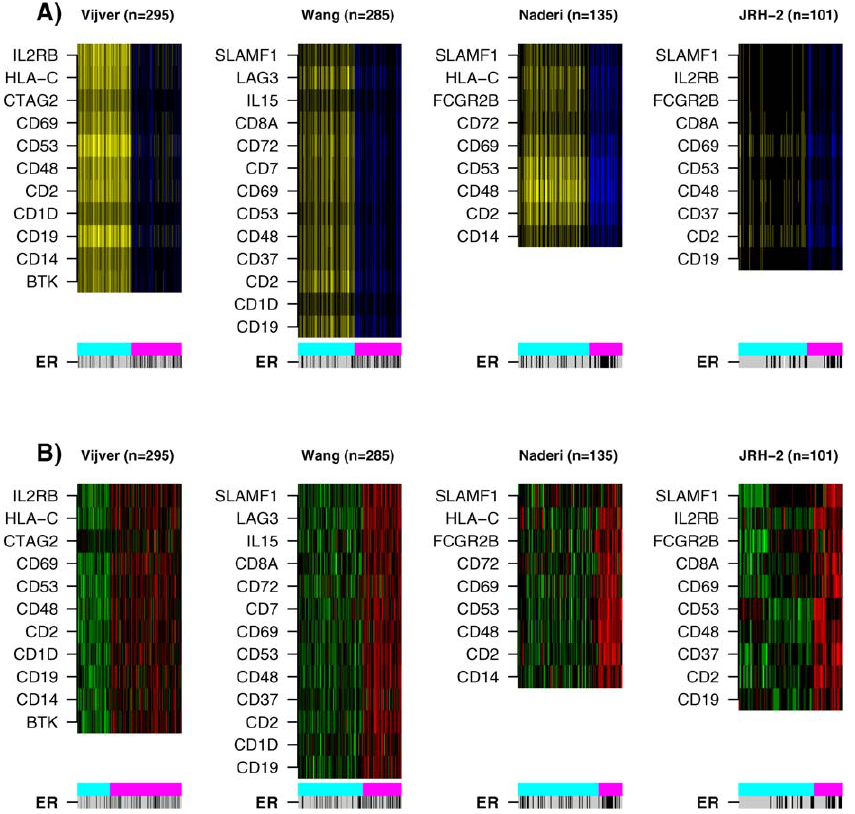
Figure 5. The Association of Immune Response with Estrogen Receptor Status (A) For each major breast cancer cohort, we give the heatmap of component expression values for the component enriched for the immune-response pathway characterised in [39]. Thus, the heatmap matrix shown is S gk A ks where k is the component enriched for the immune response pathway, g is any gene found on the array that is also in the pathway and the selected feature set of the component, and s denotes the tumour sample. Samples have been ordered according to a k-means (k ¼ 2) clustering over the set of genes. The ICA algorithm for which this heatmap is shown is the KernelICA algorithm. Blue denotes ‘‘ upregulation, ’’ yellow ‘‘ downregulation. ’’ For the samples, black denotes an ER (cid:3) and grey an ER þ tumour. (B) For each major breast cancer cohort, we give the heatmap of expression values for the same set of genes as in (A). Thus, the heatmap matrix shown is X gs where X gs denotes the measured expression level of gene g in sample s . As before, samples have been ordered according to a k-means (k ¼ 2) clustering over the represented genes. Red denotes relative overexpression, green underexpression. Magenta denotes the upregulated cluster, cyan the downregulated cluster.